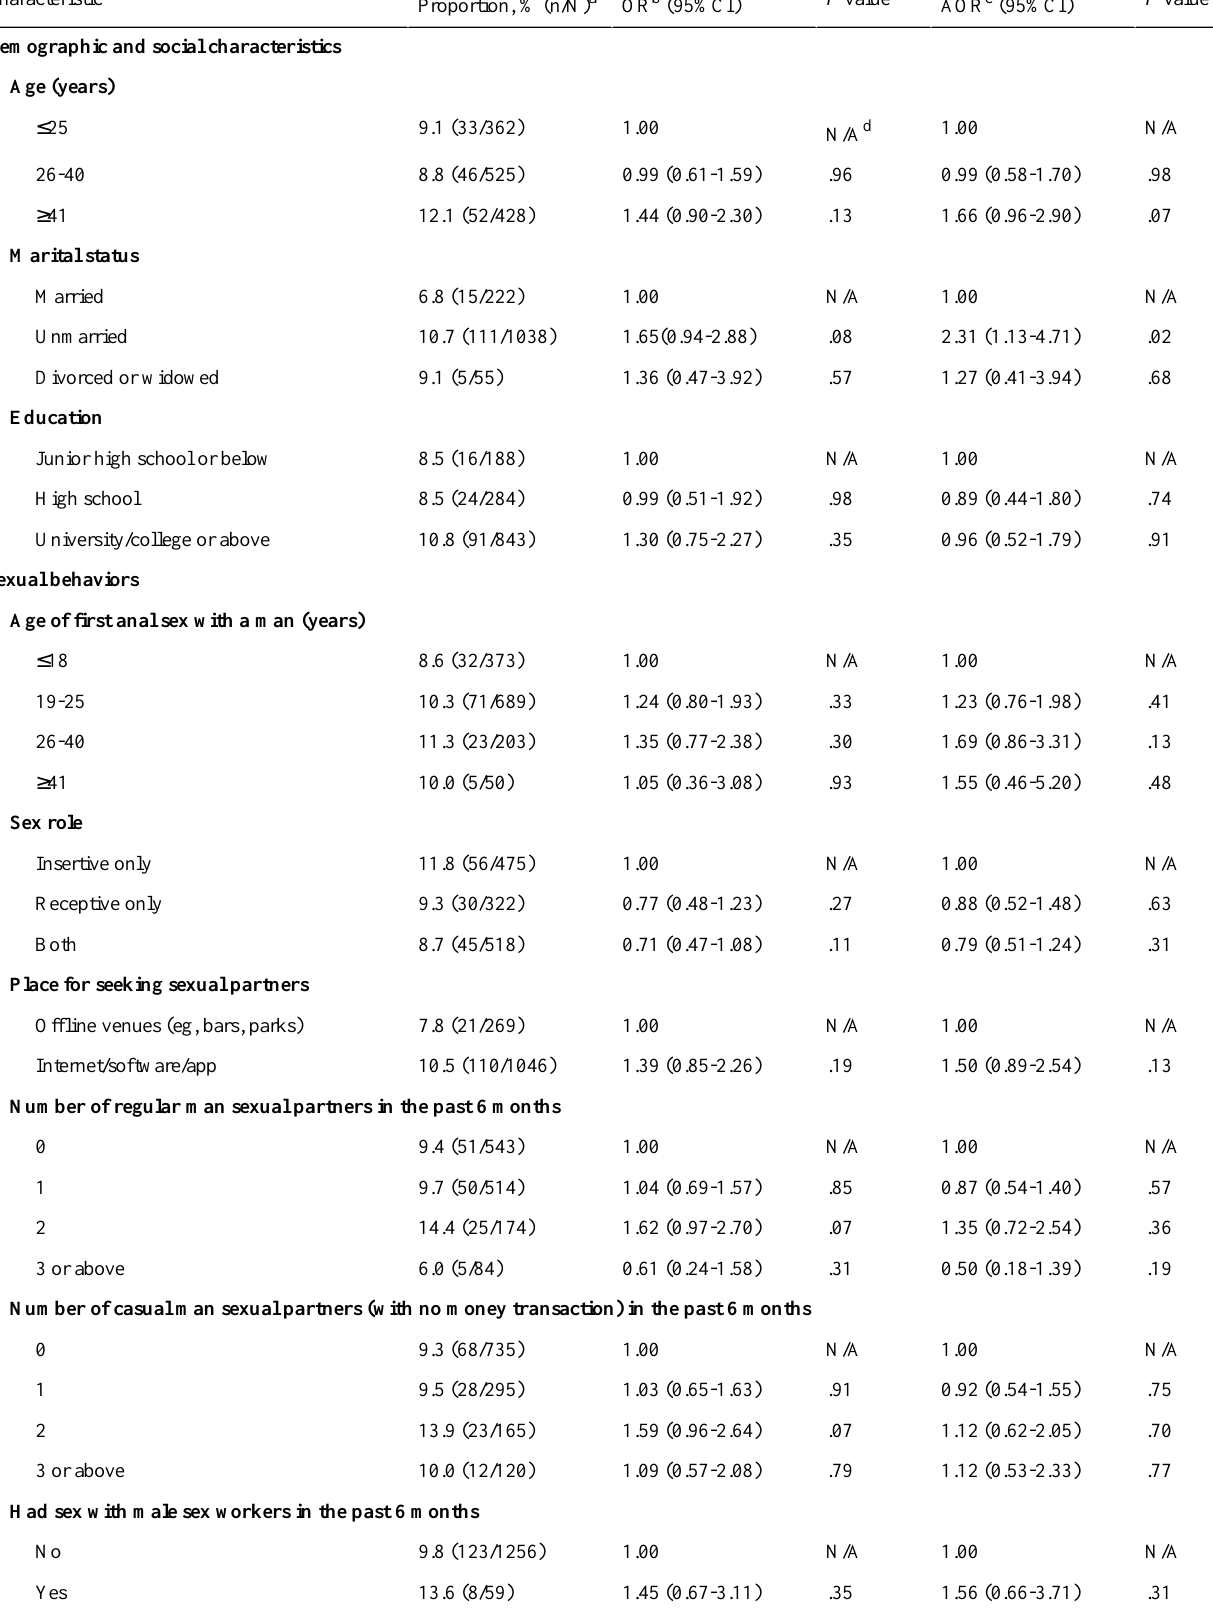
Table 2. Impact factors of HIV self-testing (HIVST)